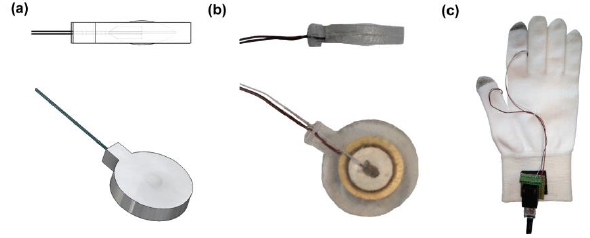
Figure 6. Embedded piezoelectric transducer. ( a , upper part ) Drawing of the lateral view of the piezoelectric transducer embedded in the polymeric matrix, with evidence of the two protrusions on the external opposite faces of the geometry; ( a , lower part ) drawing of the upper view of the piezoelectric transducer embedded in the polymeric matrix; ( b , upper part ) lateral picture of the developed prototype showing the side of the actuator; ( b , lower part ) upper picture of the developed prototype showing the whole surface of the actuator; and ( c ) a picture of the integrated system used for the psychophysical evaluation: a textile glove equipped with two encapsulated transducers on the thumb and index fingertips.